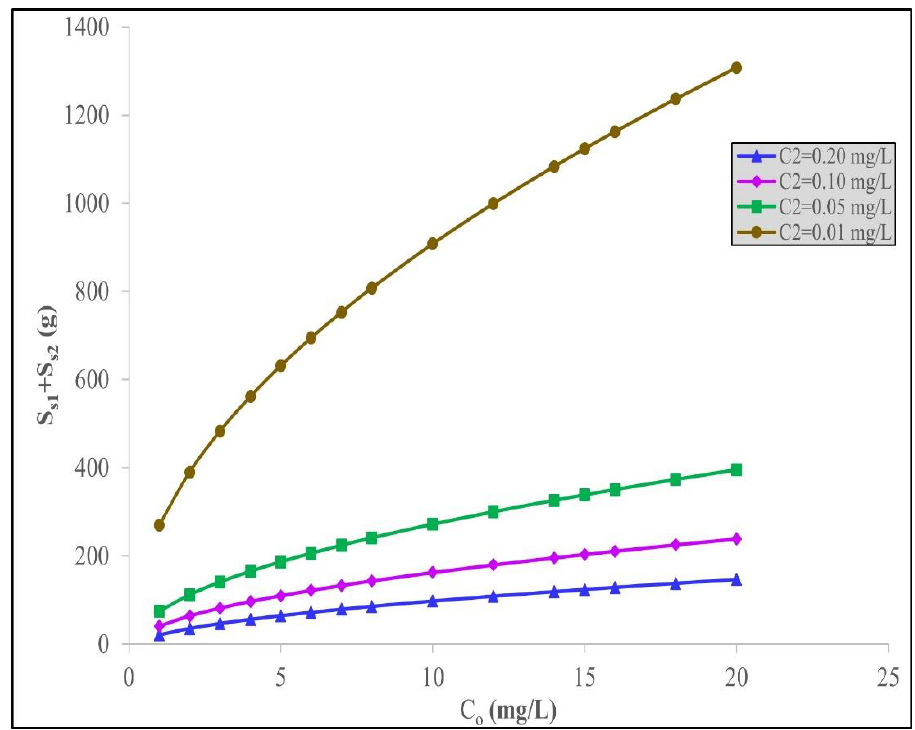
Figure 6. Minimum total quantity of acid-treated date stone carbon, S 1 + S 2 , to remove IBU applying the Langmuir – Freundlich model at different initial IBU concentrations, C 0 , for different set values of final IBU concentrations, C 2 , in the effluent.